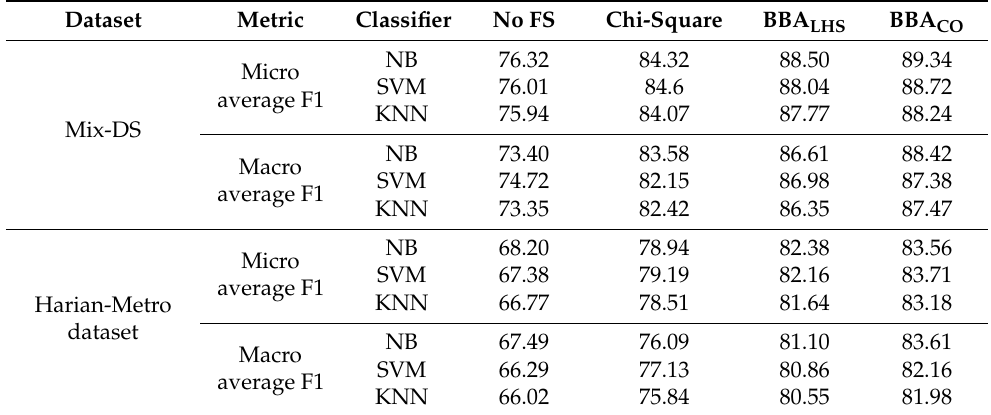
Table 18. Classification results achieved by using the original dataset, the feature sets selected by Chi-square, BBA LHS and BBA CO